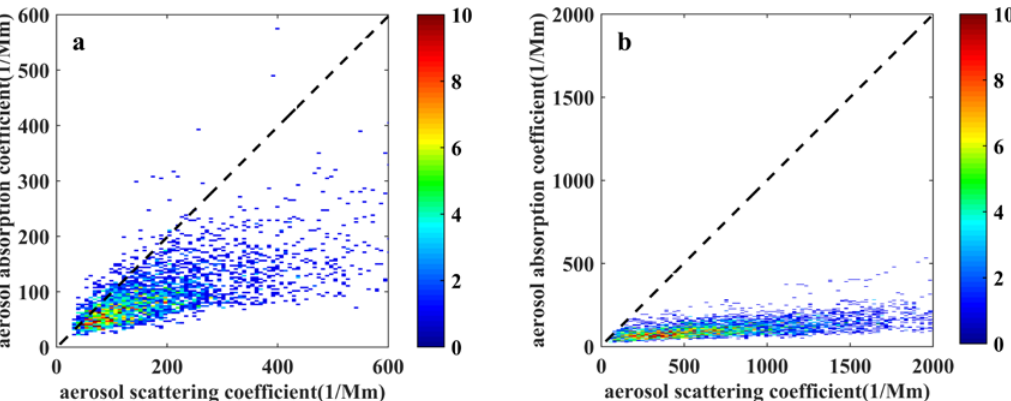
Figure 6. Relationship between aerosol scattering coe ffi cients and absorption coe ffi cients: ( a ) haze-free aerosols; ( b ) haze aerosols. The scatter points represent the number of days. The red solid circles represent high-frequency distributions. The dashed line represents the 1:1 line.